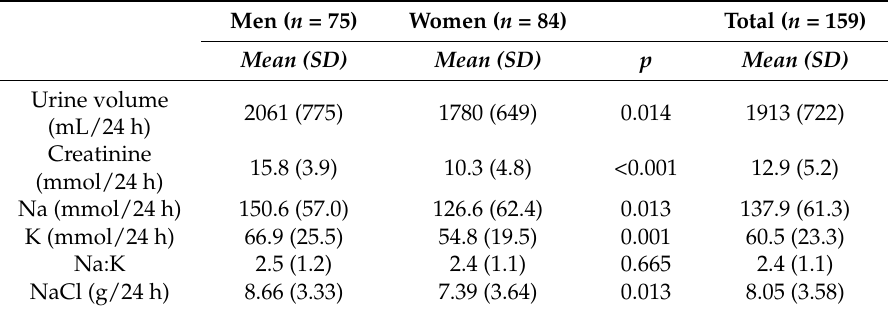
Table 2. Urine analysis laboratory data of participants who returned complete 24-hour urine samples, according to gender.